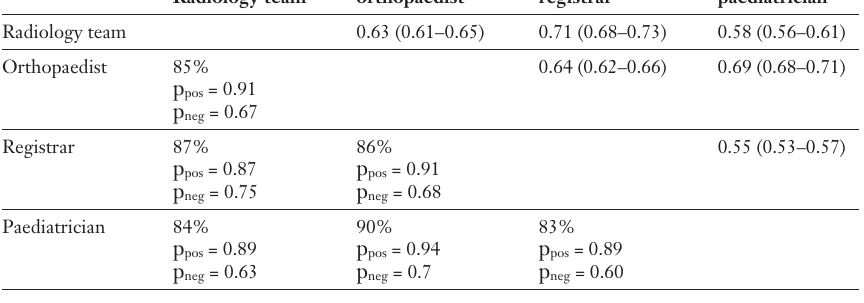
Mean values and standard deviations (SD) in degrees for the alpha and beta angles of 158 ultrasonograms.